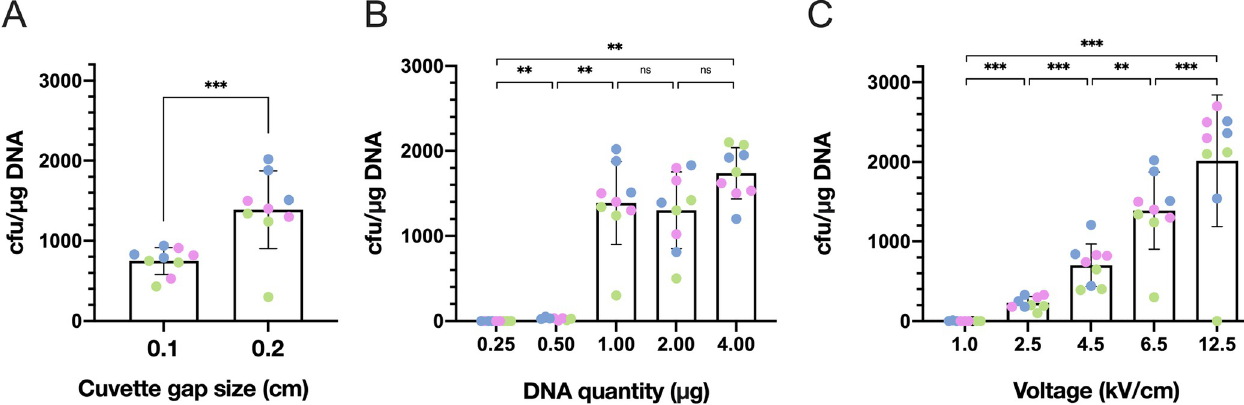
Fig 3. Optimization of electroporation procedure for L . jensenii 25258 using pTRKH2 vector. A. Increasing electroporation cuvette size yields a 2.5-fold increase in transformation efficiency. Shown are transformation efficiency of electrocompetent L . jensenii in 0.1 cm or 0.2 cm cuvette gap size. B. Increasing DNA quantity impacts transformation efficiency in a step-like manner. Shown are transformation efficiency of electrocompetent L . jensenii electroporated in 0.2 cm cuvettes with different DNA quantities, as indicated. Quantities above 4 μ g (or volume above 5 μ L) frequently result in electric arcs. C. Increasing electric pulses’ voltage improves transformation efficiency. Shown are transformation efficiencies for electrocompetent L . jensenii electroporated in 0.2 cm cuvettes with 1 μ g DNA at different voltage intensities, as indicated. Increasing the voltage above 12.5 KV/cm causes arcing and kills the cells. All electroporations were carried with vector pTRKH2, 3X SMEB, 2% glycine, 6.5 kV/cm voltage (unless otherwise indicated), 400 O resistance, 25 μ F capacitance. 3 biological replicates of 3 technical replicates were performed on different days (data are shown in S2 Table). Technical replicates are shown in the same color. (Wilcoxon signed-rank test p-value, ns p > 0.05, � p < = 0.05, �� p < = 0.01, ��� p < = 0.001 and ���� p < = 0.0001).